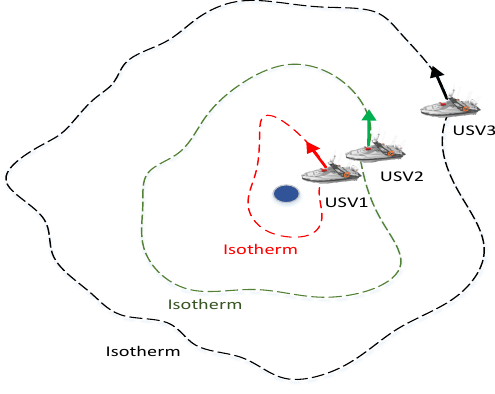
Figure 5. Multiple USVs cooperate to search isotherms.